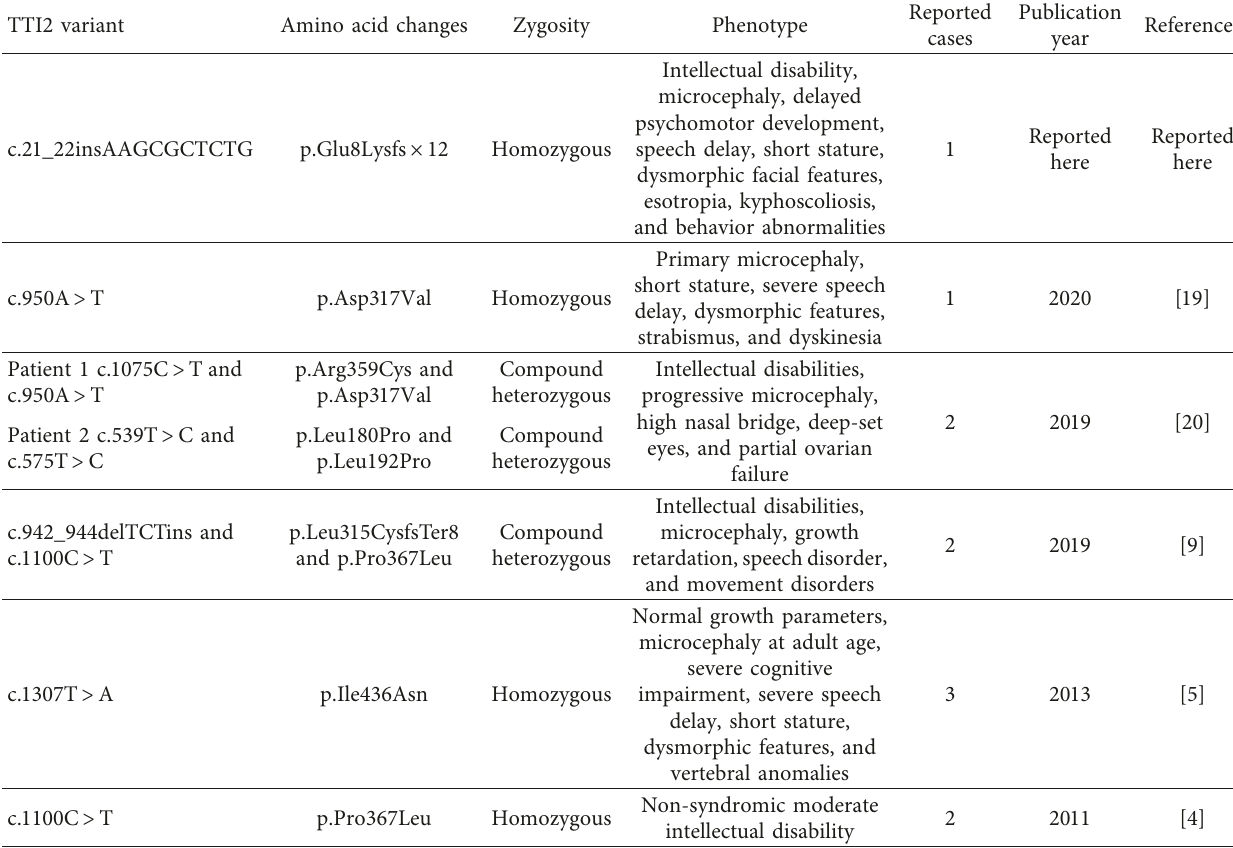
Table 1: TTI2 reported